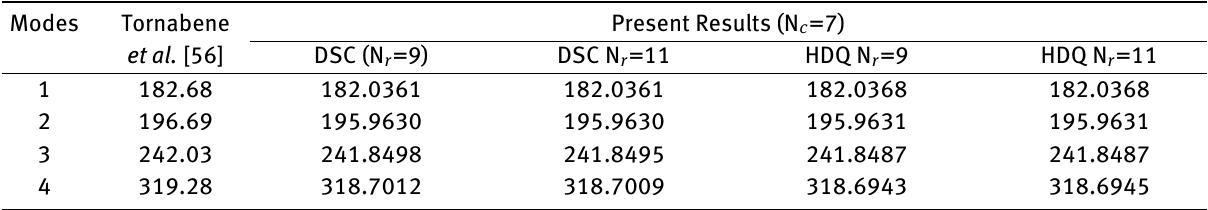
Table 2: Comparison of frequencies (Hz) of annular sector plates ( υ =0.3; α =360 0 ; ρ =7800 kg/m 3 , E=2.1 × 10 11 Pa, h=10 cm, R 1 /R 2 =0.25;